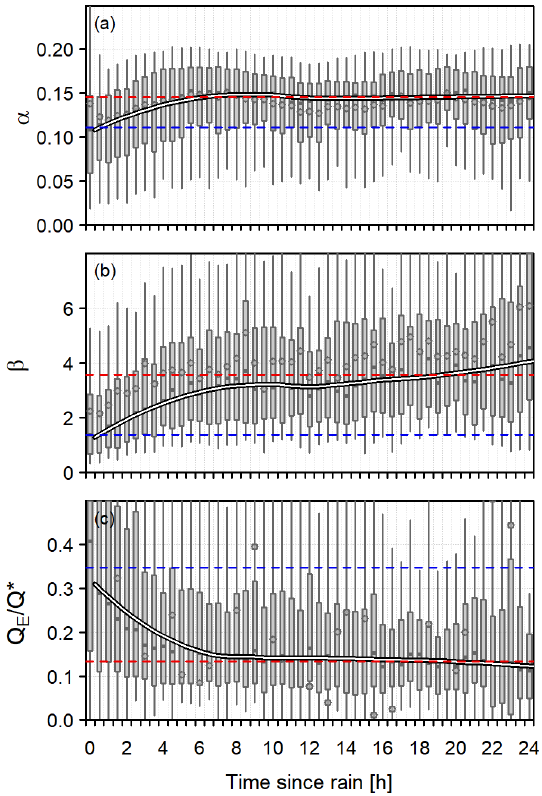
Figure 11. Box plots of (a) albedo, (b) Bowen ratio and (c) the ratio of the latent heat flux to net radiation binned by time since measured ( > 0mm) rainfall for daytime ( K ↓ > 5Wm − 2 ) data only at IAO. The thick line is a loess curve through the median values; the red dashed line indicates the mean of these values between 12 and 24h since rain (i.e. reasonably dry conditions) and the blue dashed line for the first two boxes (i.e. wet conditions less than 1h since